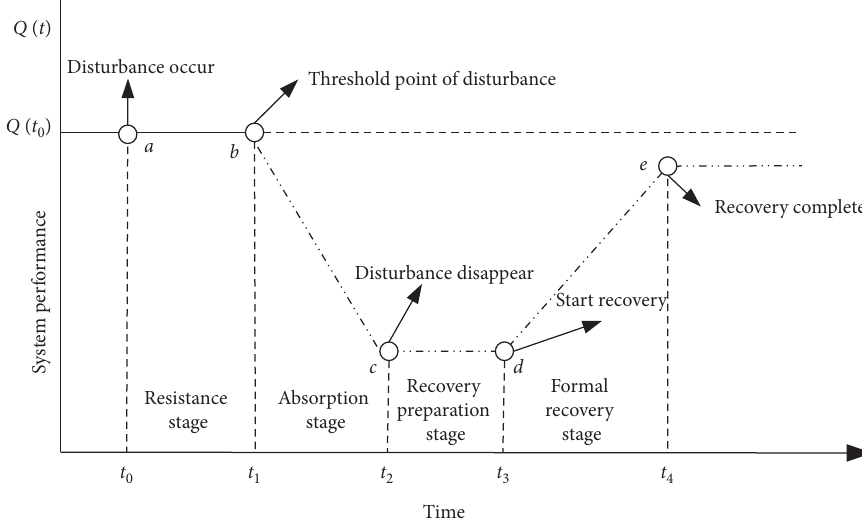
Figure 3: Formation path of cross-city transportation network